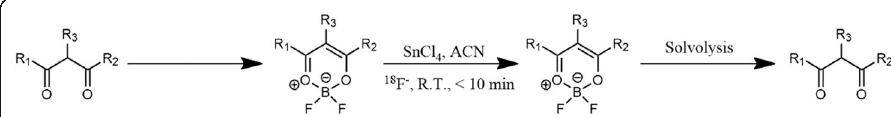
Fig. 4 Difluoro-dioxaborinins synthesis, radiosynthesis and solvolysis. Reprinted (adapted) with permission from An F, Nurili F, Sayman H, Ozer Z, Cakiroglu H, Aras O, Ting R. One-Step, Rapid, 18 F – 19 F Isotopic Exchange Radiolabeling of Difluoro-dioxaborinins: Substituent Effect on Stability and In Vivo Applications. J Med Chem. 2020;63:12693 – 12,706. Copyright (2020) American Chemical Society. Printed with permission